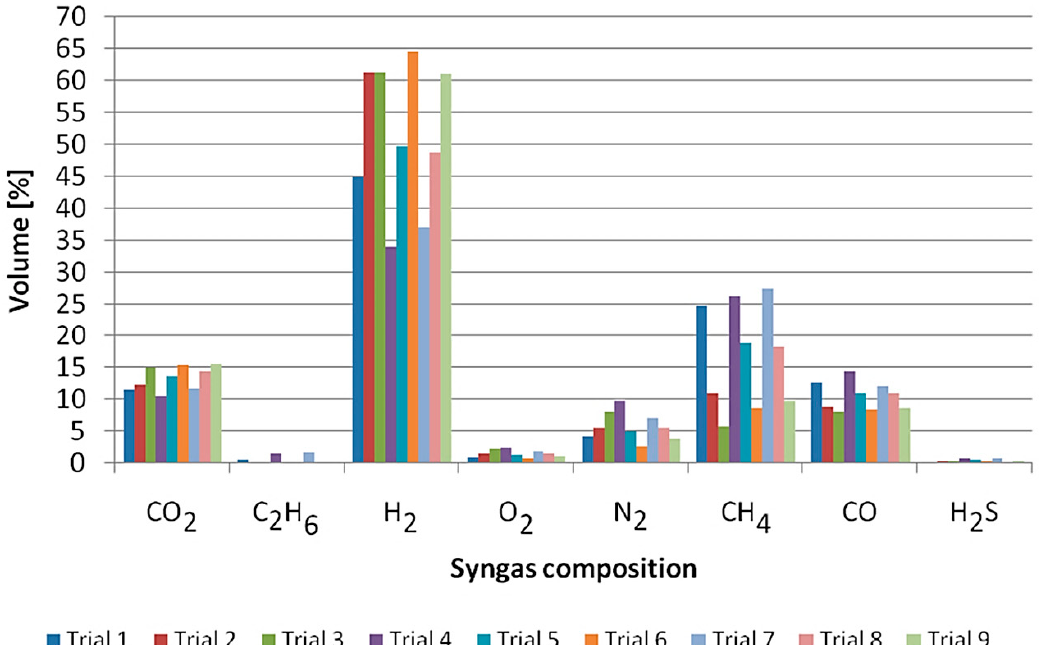
Figure 11. The effect of steam supply on the syngas composition during the gasification of the coal sample from hard coal mine A (on a dry basis).